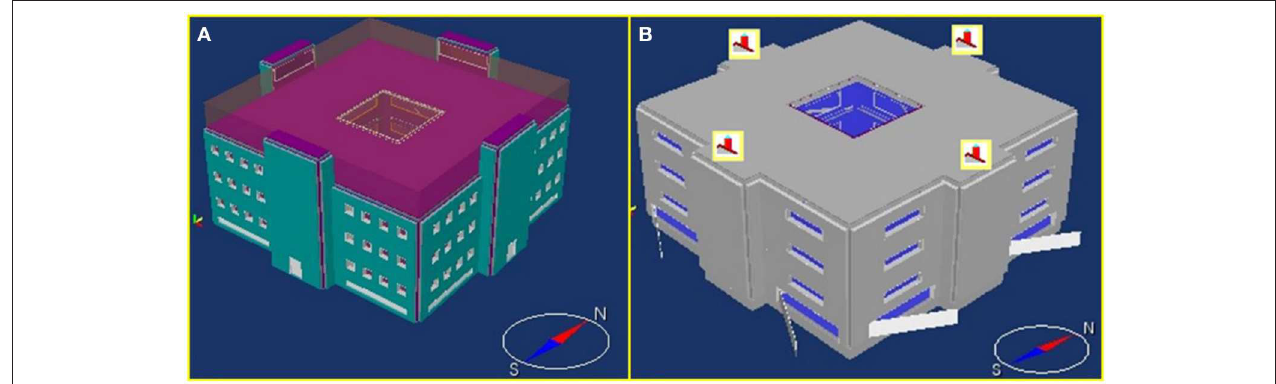
FIGURE 1 | (A) 3-D view of the building. (B) Simplified Chimney Model.